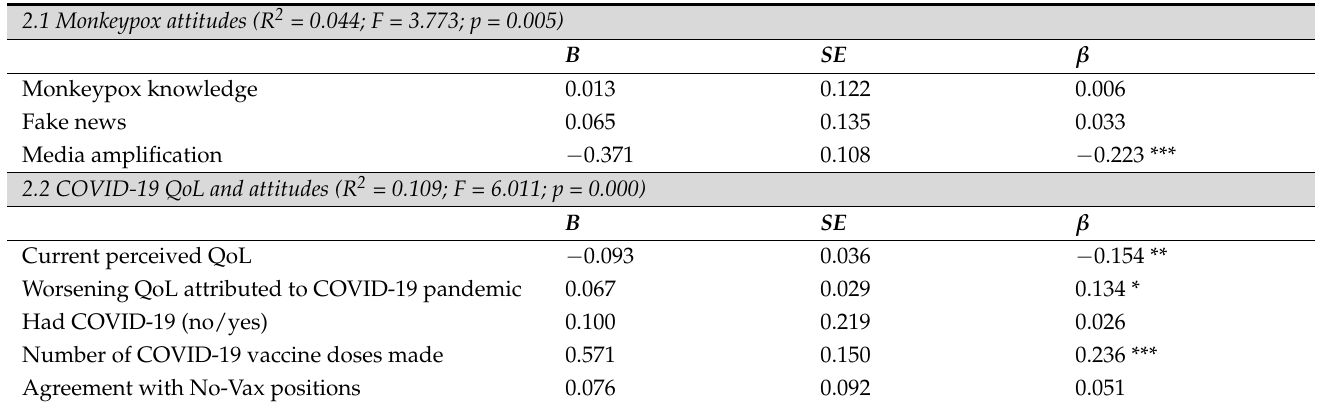
Table 4. Hierarchical multiple regression analyses on monkeypox and COVID-19-related variables (n =